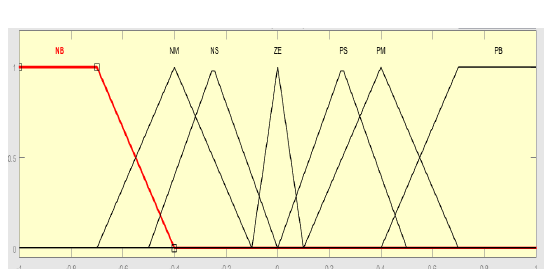
Fig 16(a): Error (e) for grid current control